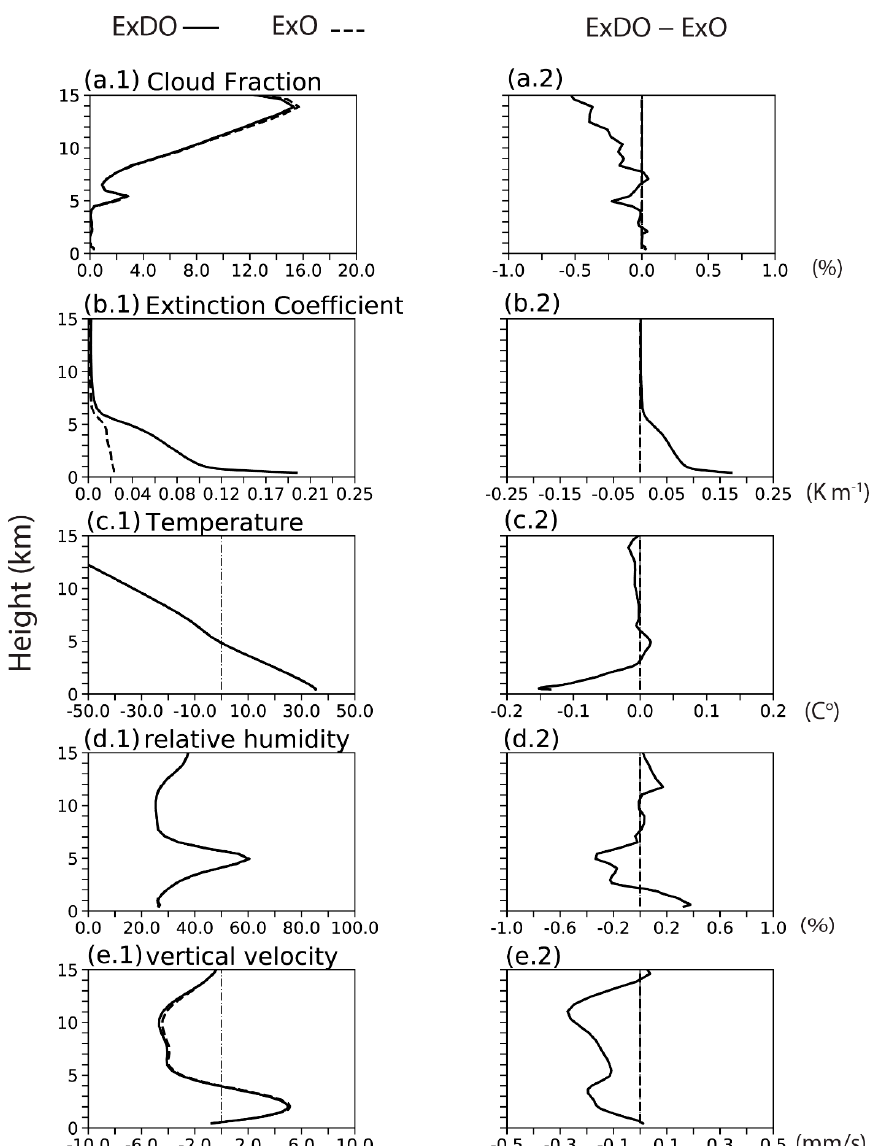
Figure 7. Time-domain averaged vertical profiles of the cloud fraction (%), the extinction coefficient (km − 1 ), the temperature (°C), the relative humidity (%), and the vertical velocity (mm/s). The domain where the averages are taken is indicated in Figure 1a. The average period is from 1300 UTC 21 to 0000 UTC 23 August 2010. The panels in the left column are from ExDO (solid line) and ExO (dash line). The panels in the right column are their differences (ExDO − ExO).